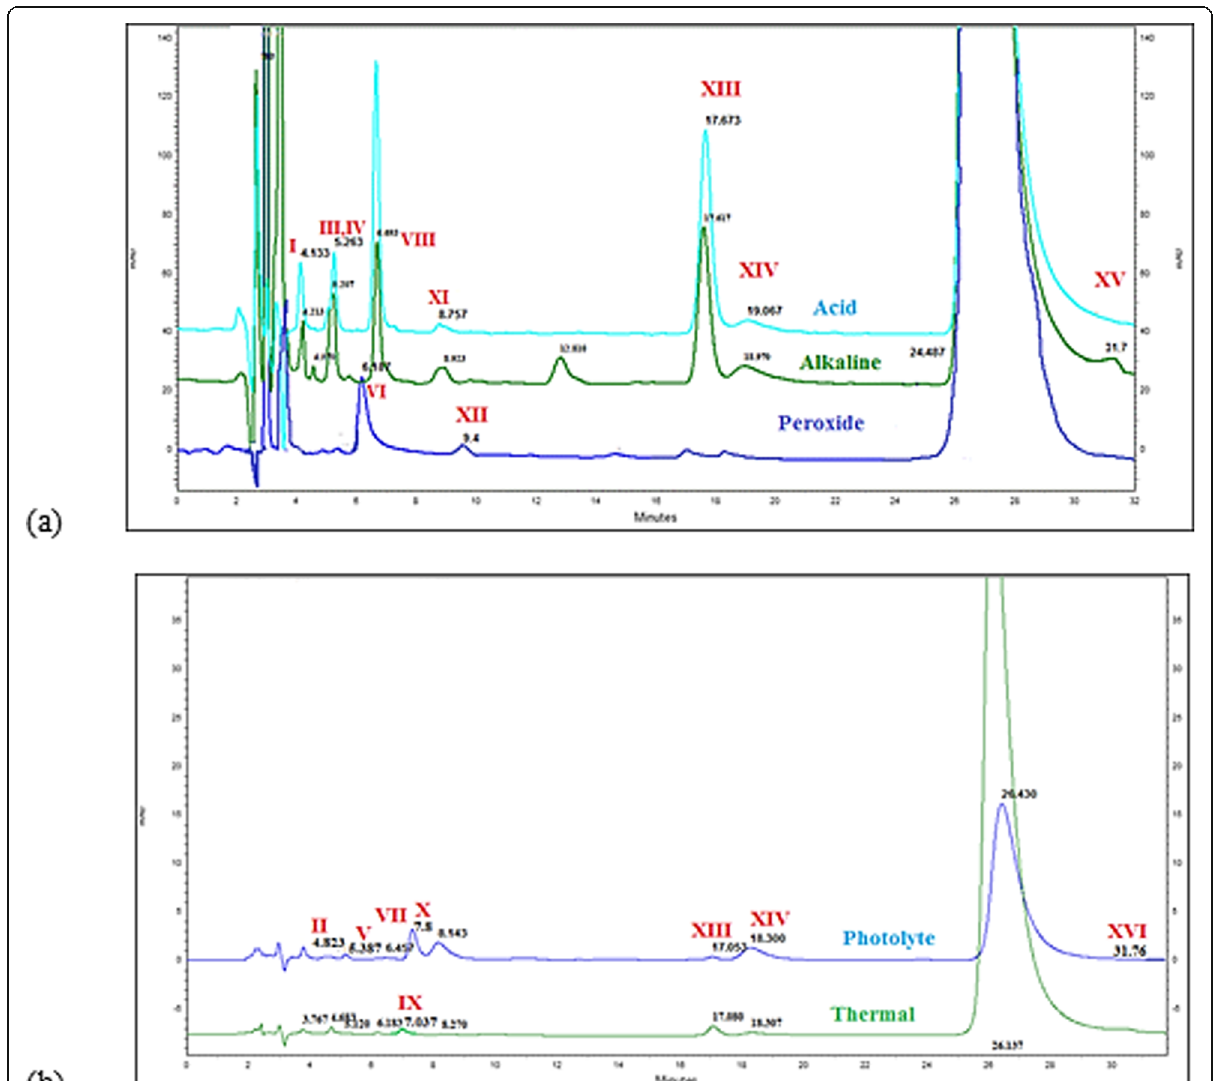
Fig. 6 Overlay chromatogram of AV (100 μ g/mL) in ( a ) acid hydrolysis, alkaline hydrolysis and peroxide and ( b ) photolytic and